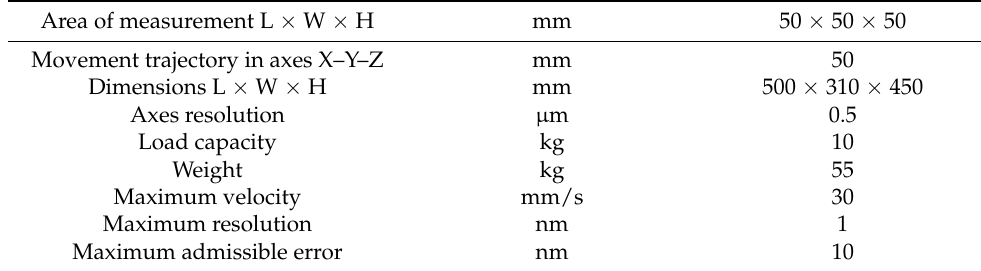
Table A3. Surface quality measurement